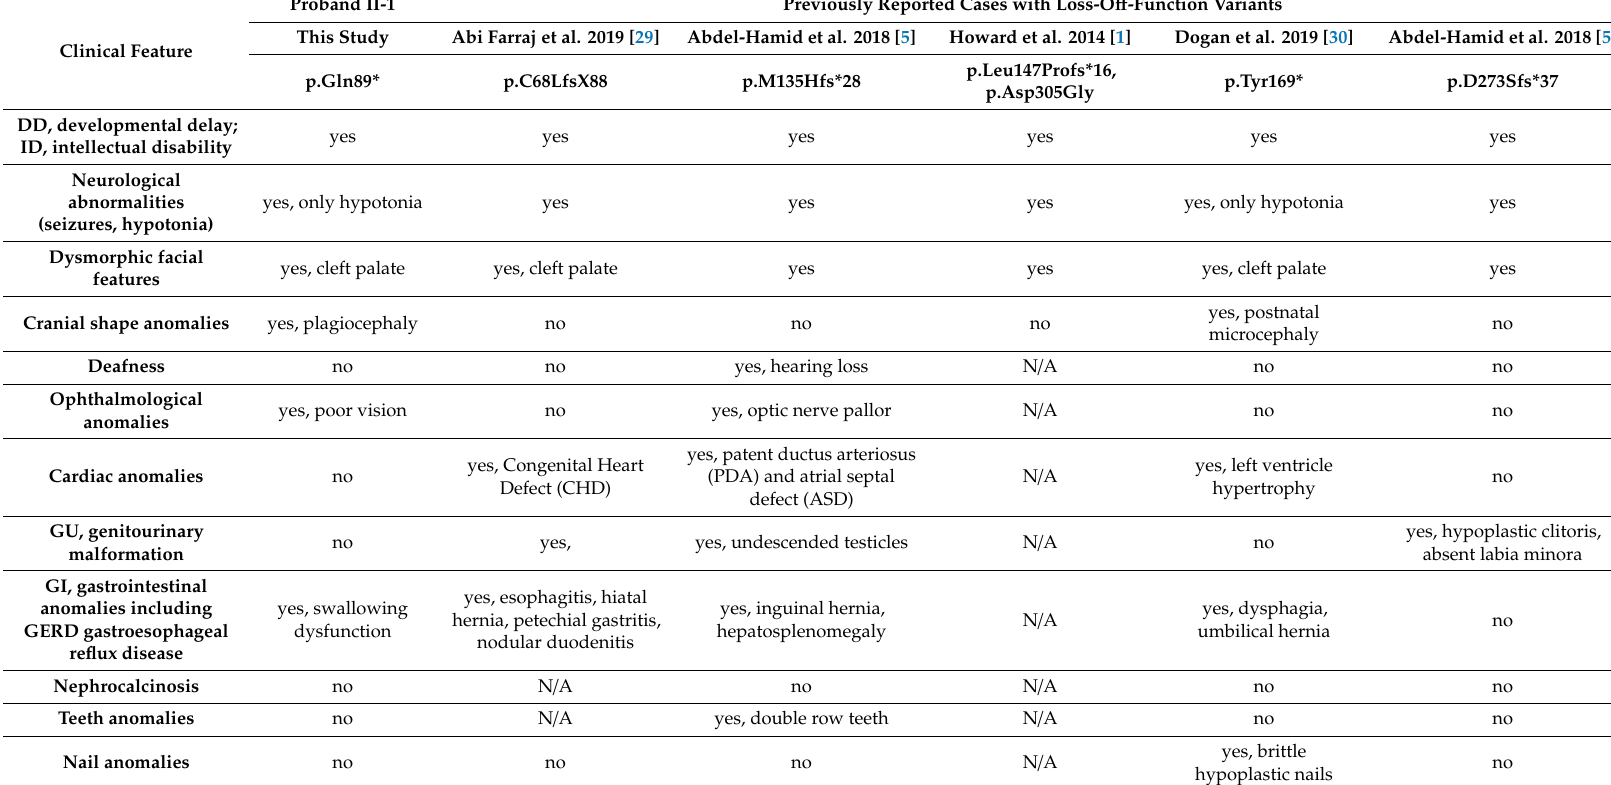
Table 1. Clinical features of the study proband and previously reported cases with PGAP3 frameshift or protein-truncating mutations. Abbreviations: DD, developmental delay; ID, intellectual disability; GU, genitourinary; GI, gastrointestinal; GERD, gastroesophageal reflux disease; MRI, magnetic resonance imaging; CT, computed